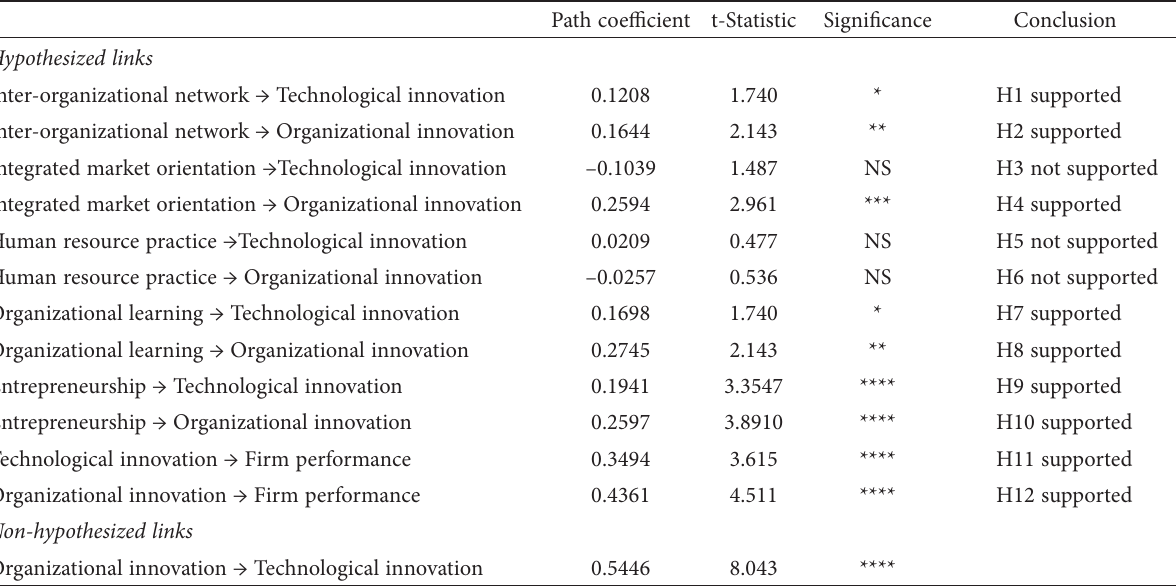
Table 5. Structural effects among all latent constructs Path coefficient